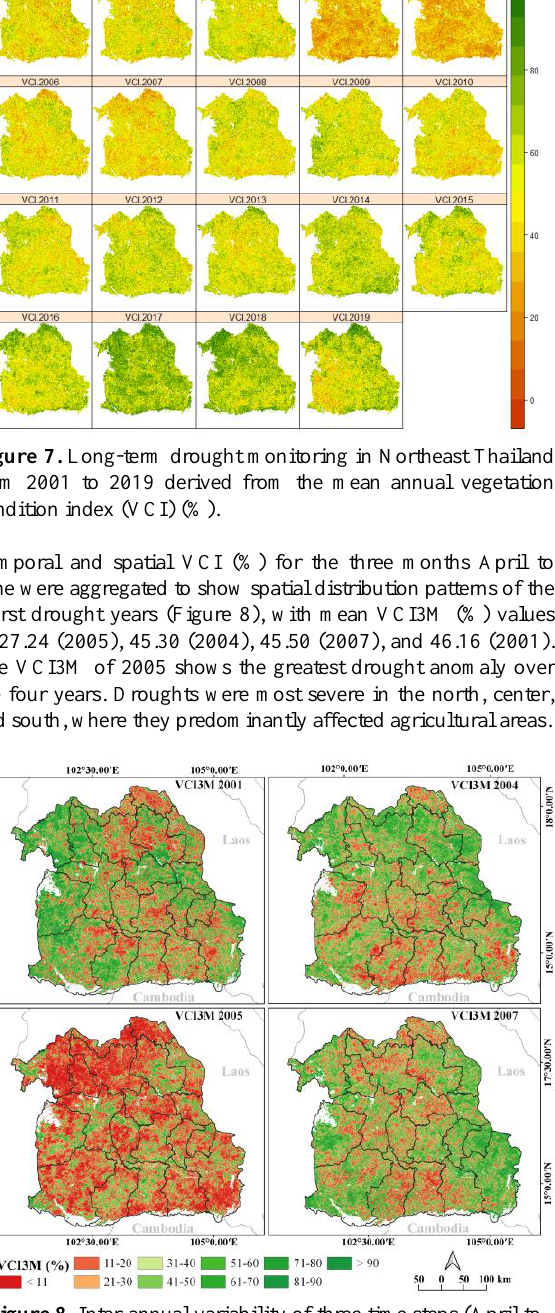
Figure 8. Inter-annual variability of three time steps (April to June) for drought in Northeast Thailand in 2001, 2004, 2005, and 2007 based on the vegetation condition index (VCI)